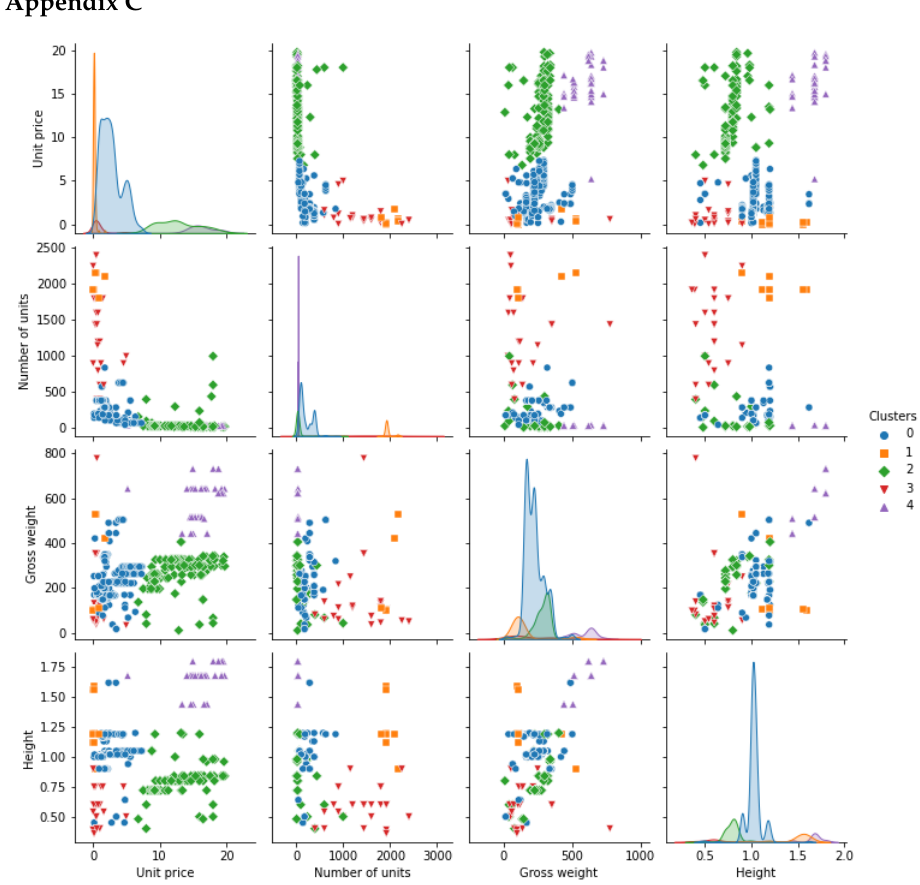
Figure A3. Pairwise view of features after clustering. Diagonal plots demonstrate the marginal distribution of each feature within each cluster (numbered from 0 to 4).